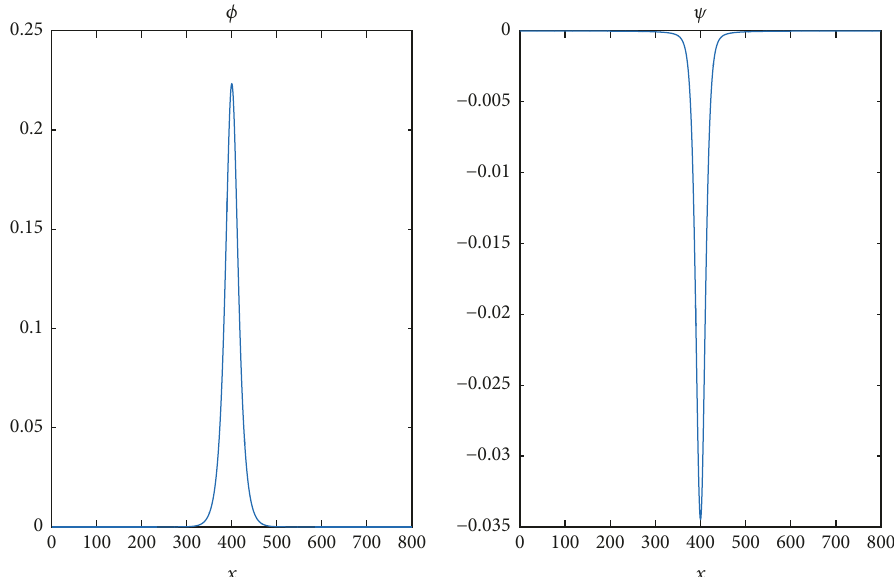
Figure 13: Approximations of the functions 𝜙, 𝜓 in the solitary wave solution (39) with 5 Newton’s iterations. The model’s parameters are 𝛼 = 𝛽 = 0.4 , 𝛾 = −1 , 𝑤 = 0.07 , and wave speed 𝑐 = 0.5 .